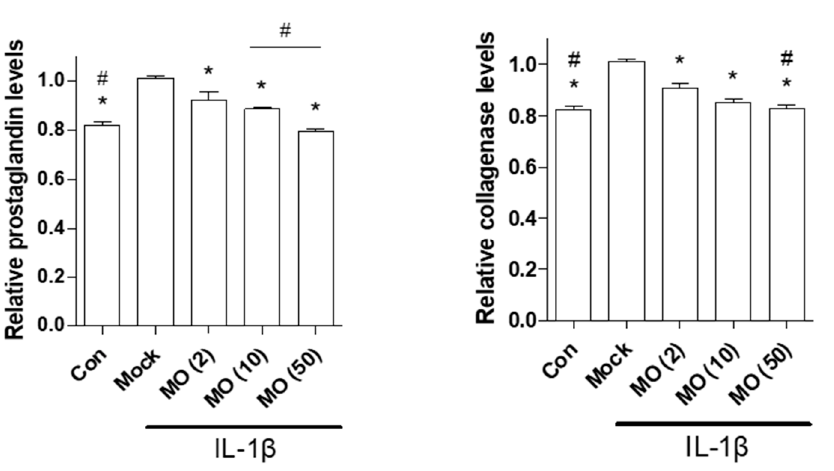
Figure 4. Effects of morroniside on prostaglandin E2 (PGE2) and collagenase secretion in IL-1 β induced mouse primary chondrocytes. Cells were incubated with IL-1 β (1 ng/mL) and cotreated with morroniside (2, 10, and 50 μ M) for 48 h. PGE2 and collagenase levels in the total cell supernatant were determined. The results of triplicate experiments were evaluated by one-way ANOVA (Tukey’s honestly significant difference post hoc test). * p < 0.05 vs. Mock, # p < 0.05 vs. MO (2). Con; control, Mock; nontreated; MO, morroniside; IL-1 β , interleukin-1